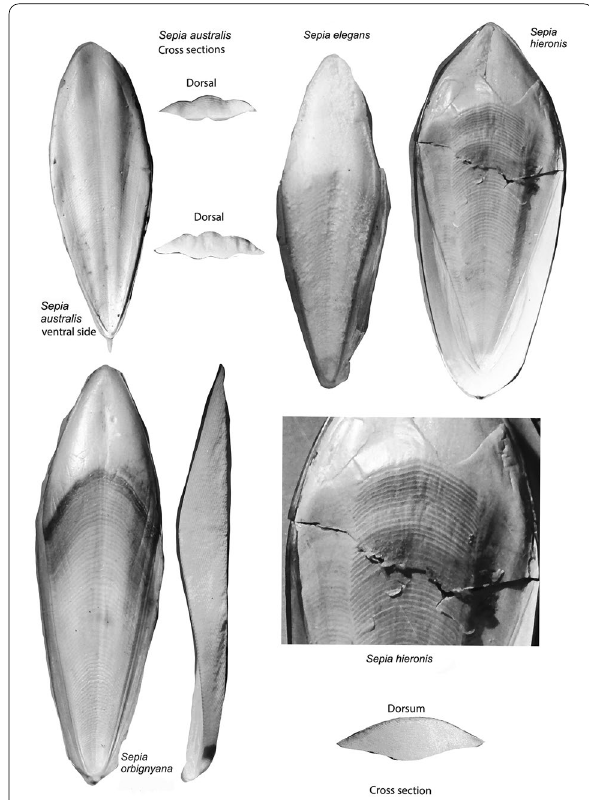
Fig. 4 Deep water cuttlebones. Shorter than shallow water, with internal curvature of chambers and dorsal shield strengthening. High septal density, curvature of both internal septa and dorsal shield, which show series of ribs, or central rib for overall